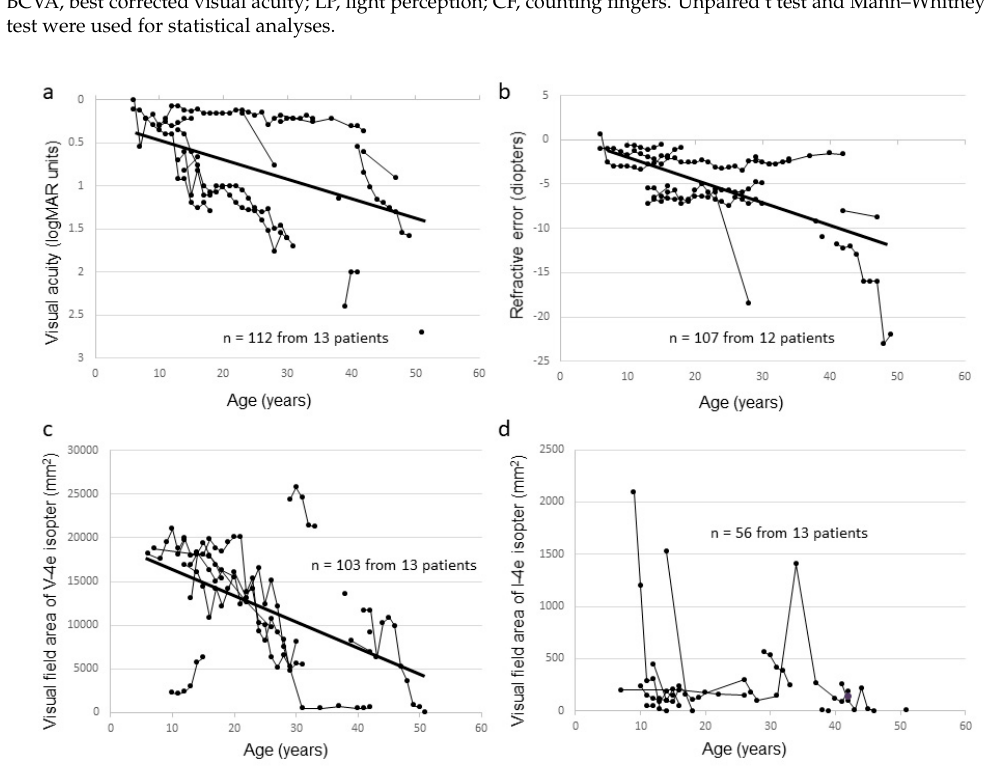
Figure 2. Correlation between visual function and age among affected male subjects in this study. The graphs show visual acuity values expressed in logMAR units ( a ), refractive error ( b ), visual field extent with the V-4e isopter ( c ), and visual field extent with the I-4e isopter ( d ) versus age. The data from the same subject are indicated using bars connecting the points.